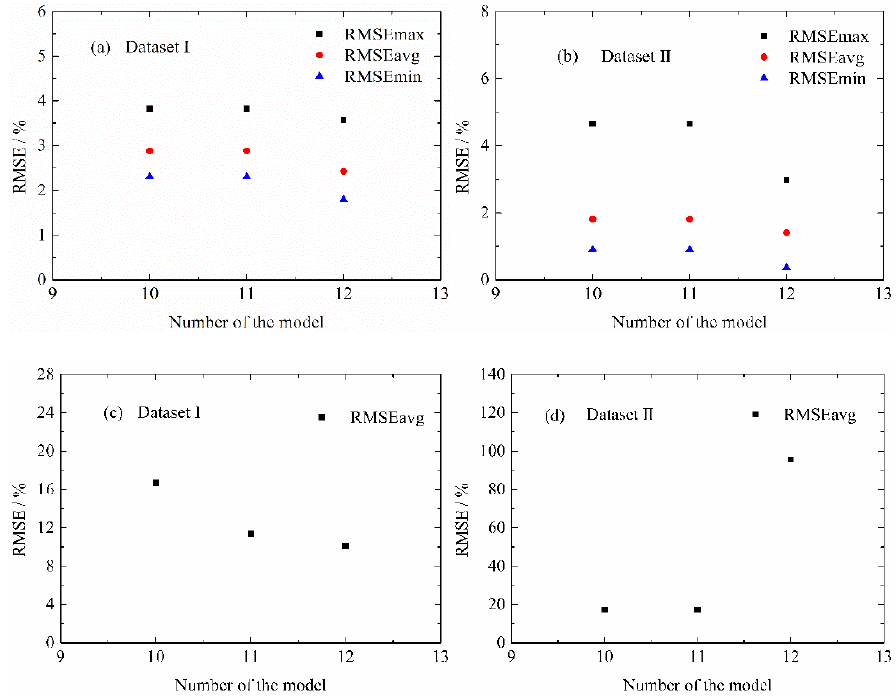
Figure 5. Prediction RMSE of the single-factor models for normal aging: ( a ) on the train dataset of Dataset Ⅰ, ( b ) on the train dataset of Dataset Ⅱ, ( c ) on the test dataset of Dataset Ⅰ and ( d ) on the test dataset of Dataset Ⅱ .